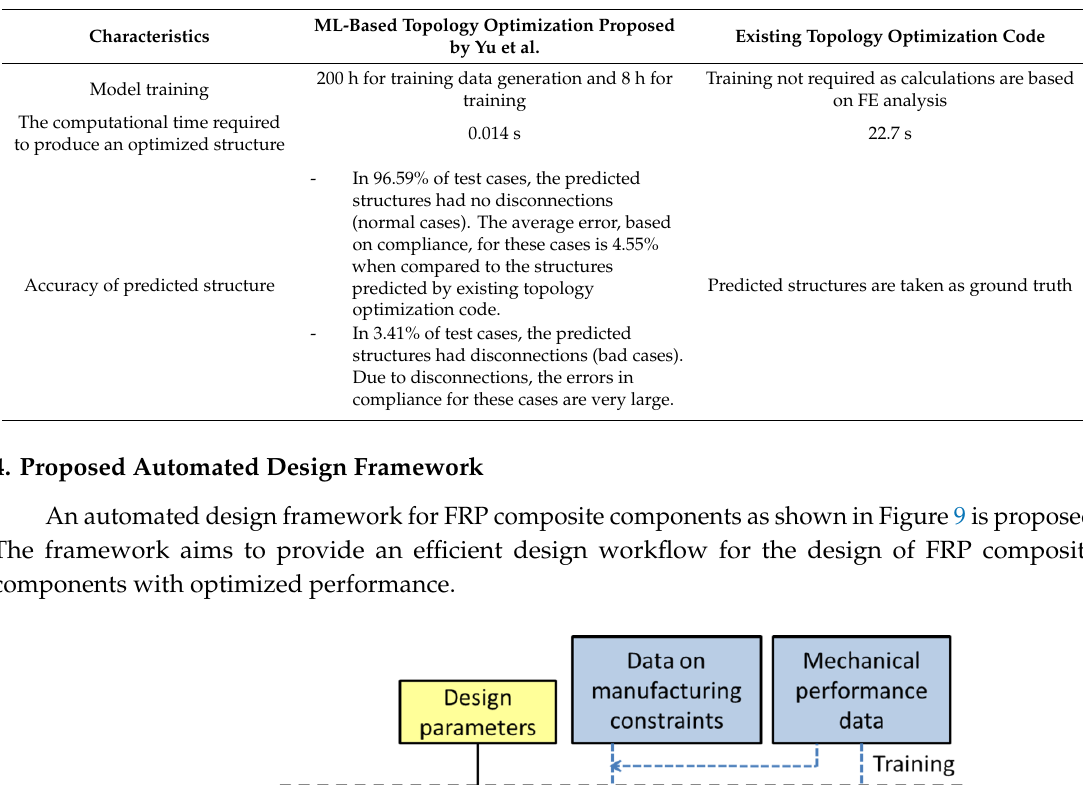
Table 1. Performance summary of the machine learning (ML)-based topology optimization method proposed by Yu et al. [25].